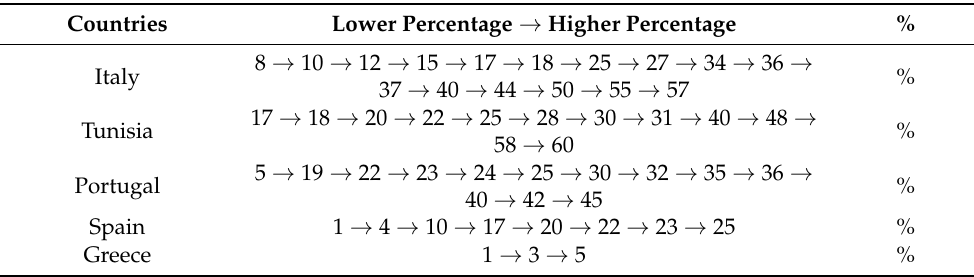
Table 1. Percentages of the oils from different countries making up the organic EU community and non-community EVOO blends. The information of the blends composition was reported on the label of each sample.